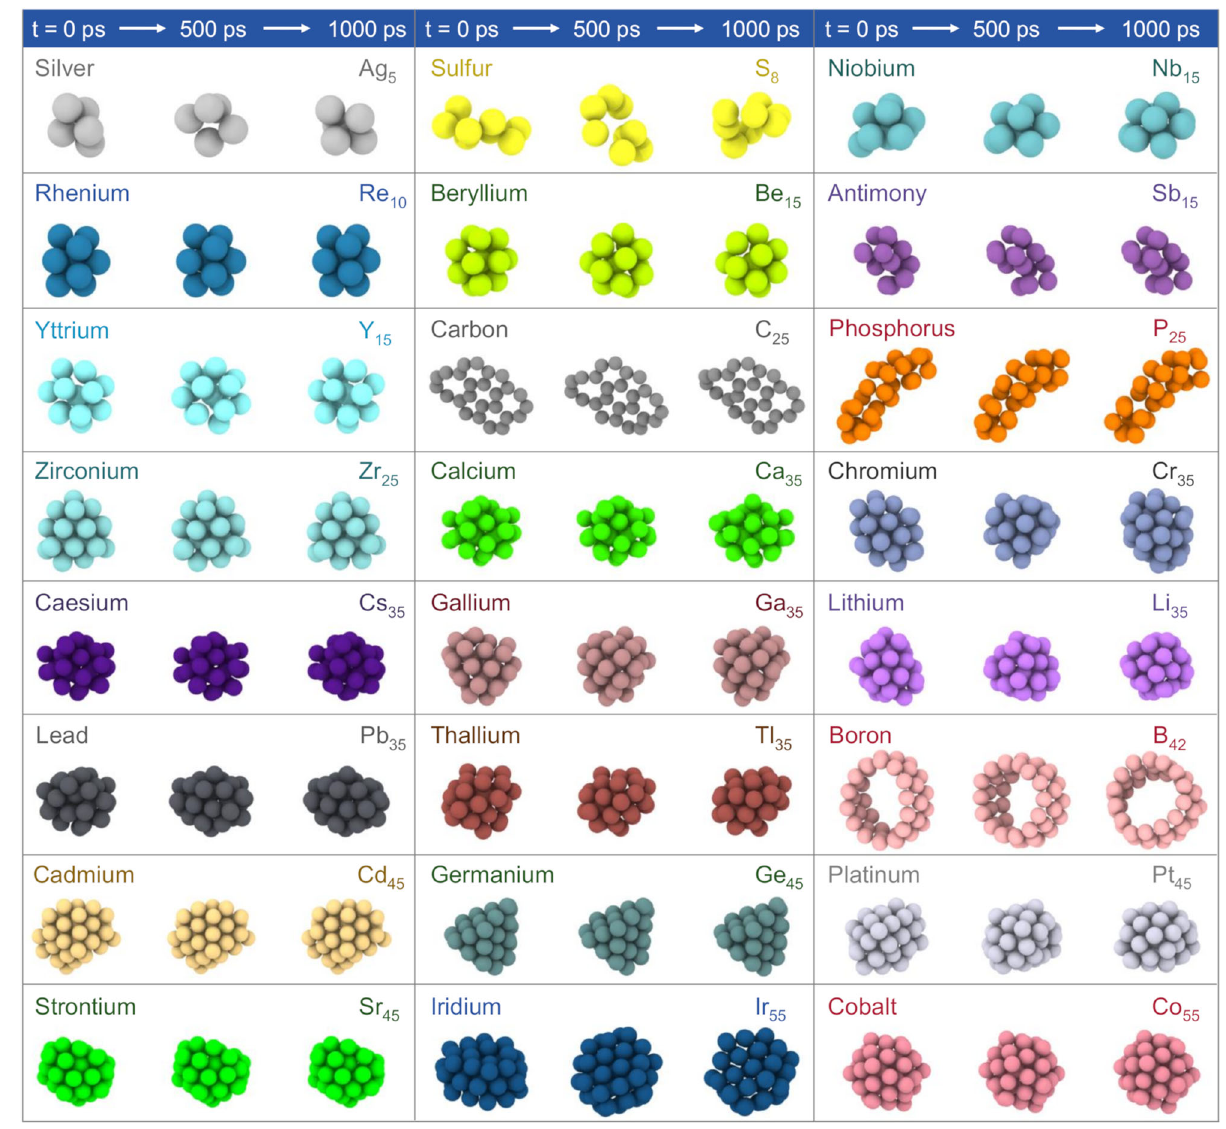
Fig. 4 Dynamic stability of the clusters of various representative elemental systems. Snapshots sampled from 1 nanosecond MD simulation trajectories illustrate the dynamic stability of the clusters of representative topologies and sizes for the different elements. To rigorously test the dynamic stability, MD simulations were performed for >40,000 nanoclusters for the 54 different elements in different size ranges. More detailed MD trajectories for each element and the simulated temperatures are included in the Supplementary Note 7 Section